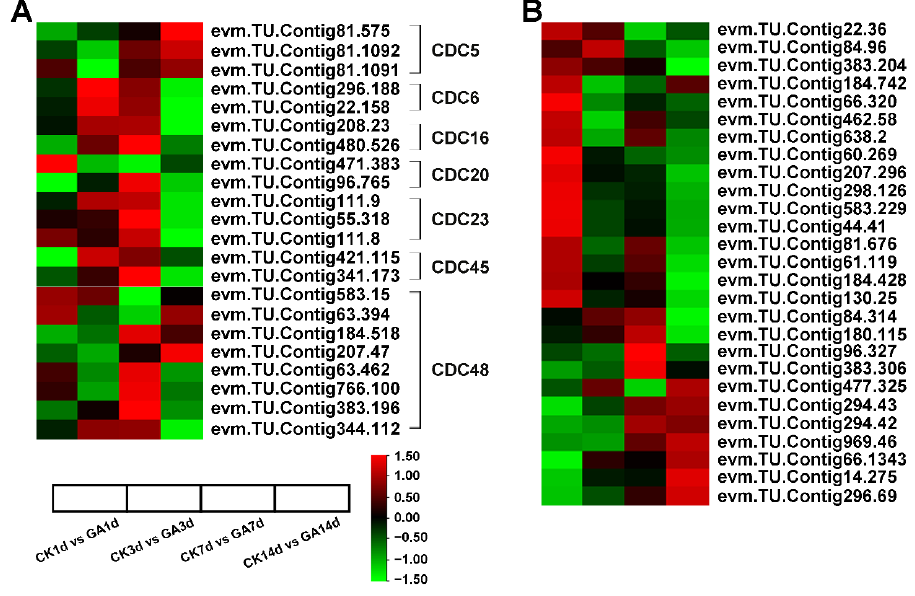
Figure 6. The analysis of DEGs associated with cell division and expansion on exogenous GA treat- ment from RNA-seq data. ( A ) The analysis of CDCs related to cell division on exogenous GA treat- ment. The expression of the mostly CDCs was up-regulated at GA7d vs. CK7d and GA14d vs. CK14d in N. cadamba . ( B ) The analysis of genes edited Expansins proteins involved in cell expansion on exogenous GA treatment. The expression of the mostly EXPANSINS genes was up-regulated at GA1d vs. CK1d, GA7d vs. CK7d, and GA14d vs. CK14d in N. cadamba . Data is shown with log2 (Fold Change) analysis. Heatmap of columns and rows represent samples and genes, respectively.